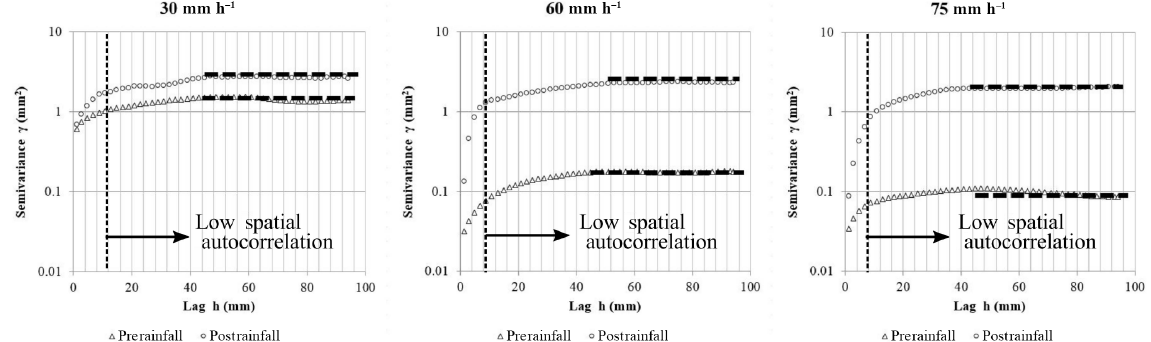
Figure 6. Semivariograms at the region of interest for the three experimental tests, under pre- and postrainfall conditions. Horizontal dashed lines indicate the semivariogram sills and vertical dashed lines indicate the lag distance above which the spatial autocorrelation of the elevations is negligible.